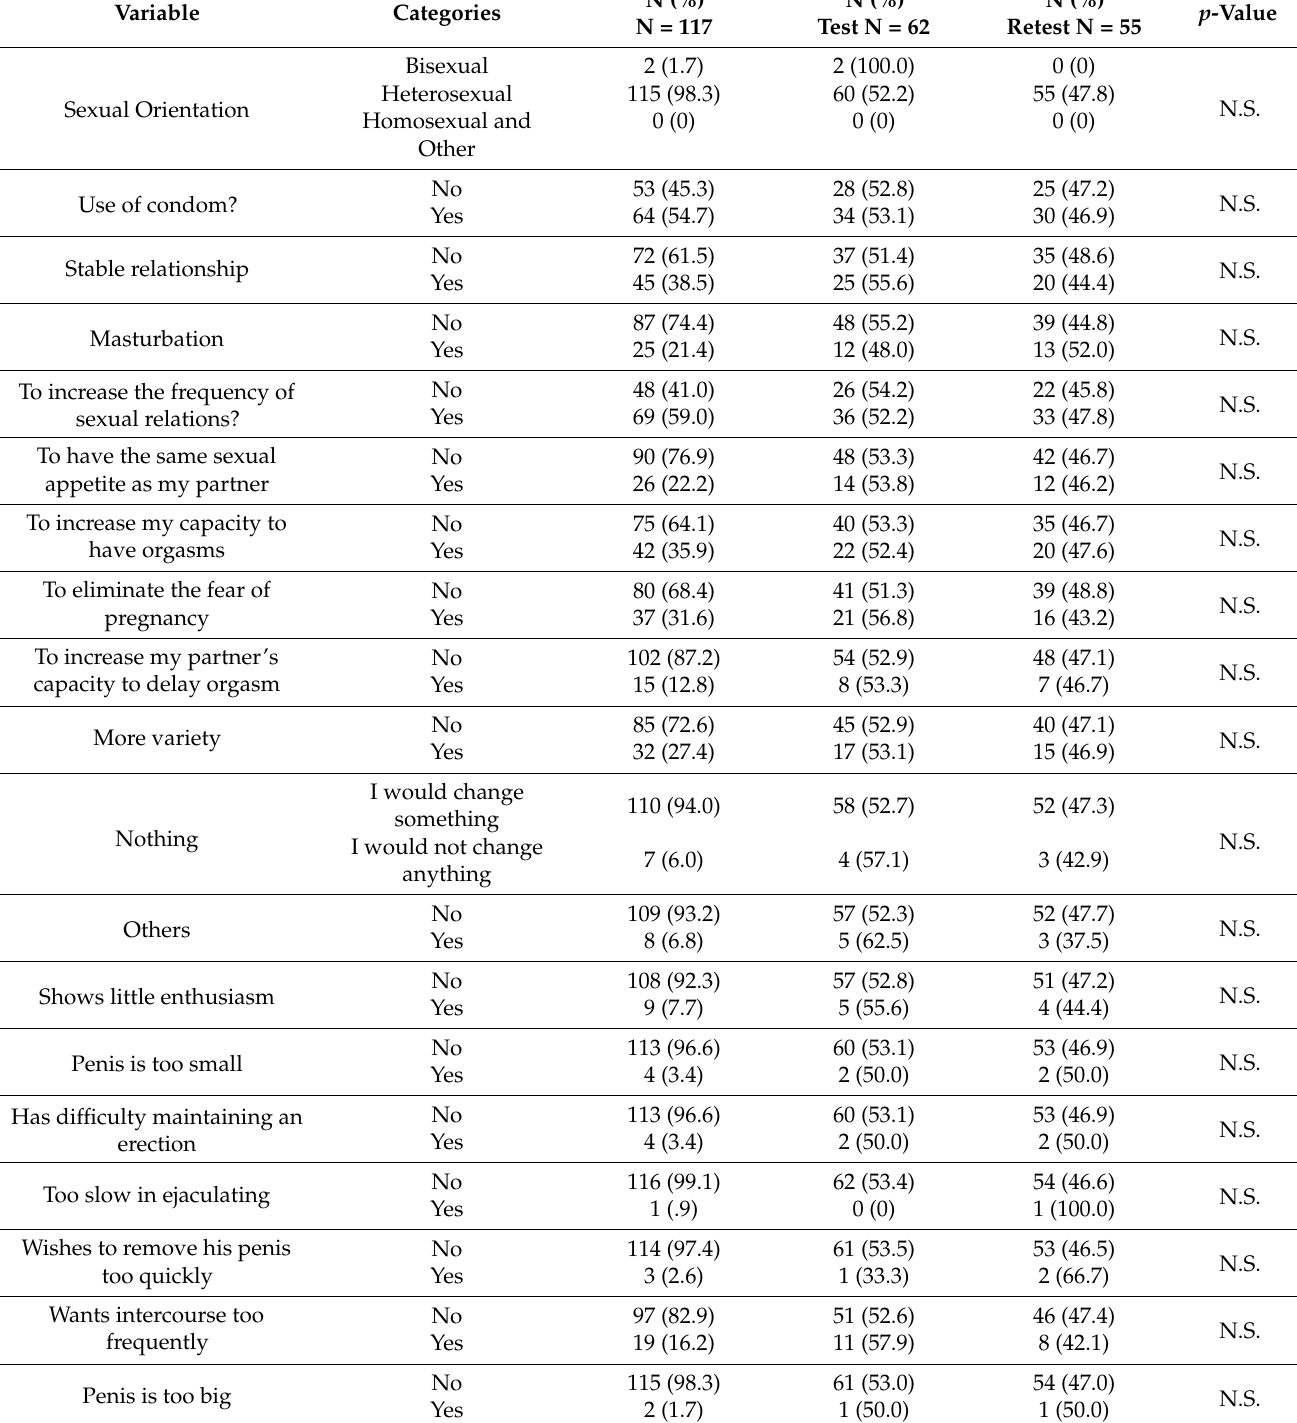
Table A1. Test–retest reliability. Descriptive and bivariant